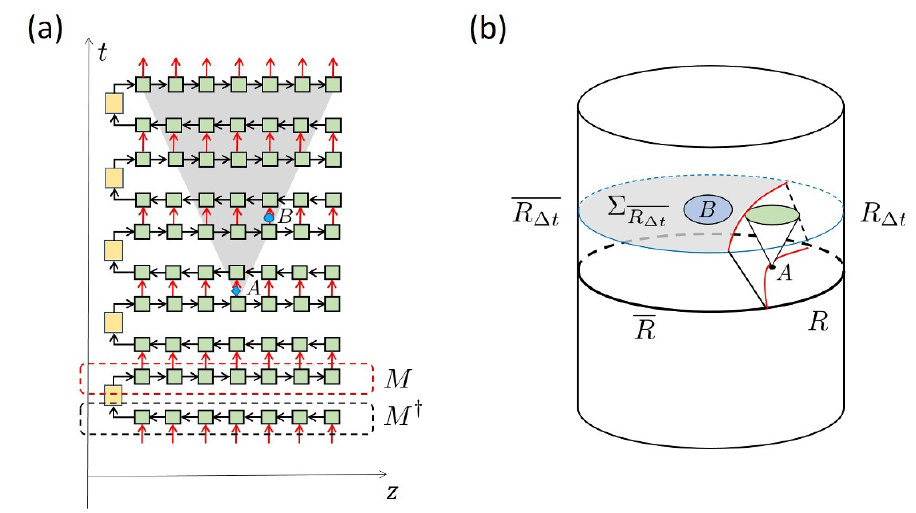
Figure 20 . Causal in(cid:13)uence for two bulk regions at di(cid:11)erent times. (a) Bulk time evolution is de(cid:12)ned by pulling back the boundary time evolution using a holographic tensor network (see text). (b) An illustration in a (2+1)d bulk. An operator on a small region A can be reconstructed in a boundary region R , which evolves into a slightly bigger region R (cid:1) t after a short time (cid:1) t . Therefore, all operators in the complement entanglement wedge (cid:6) still commute with the operator at A R (cid:1) t